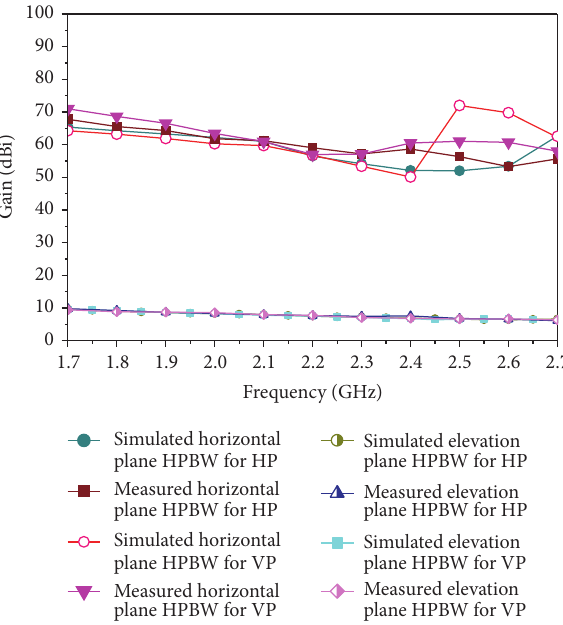
Figure 8: HPBWs of the V/H dual-polarized antenna array.